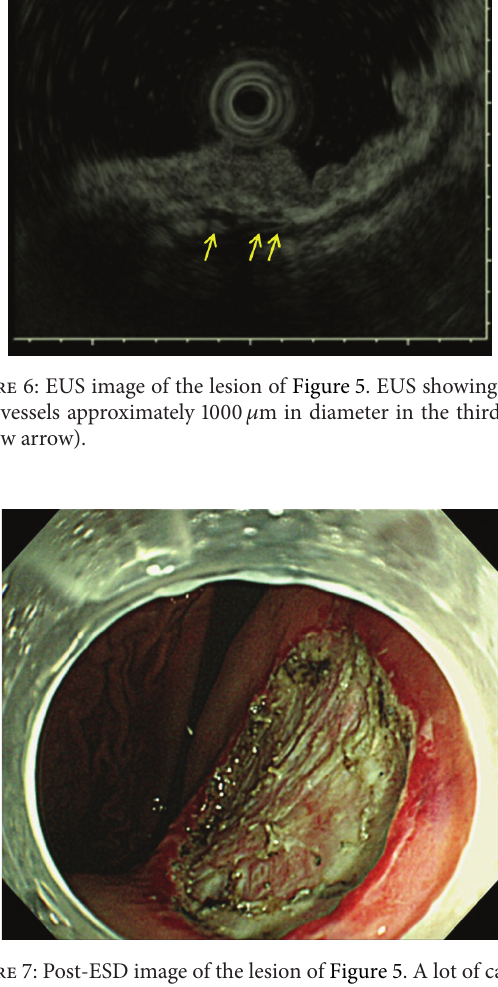
Figure 7: Post-ESD image of the lesion of Figure 5. A lot of carbide by hemostatic forceps and muscle injury were recognized on ESD